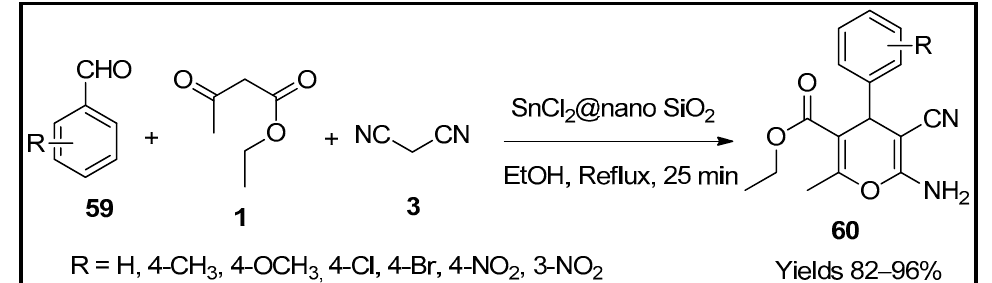
Scheme 20. Pyran derivatives synthesised by SnCl 2 @nano SiO 2